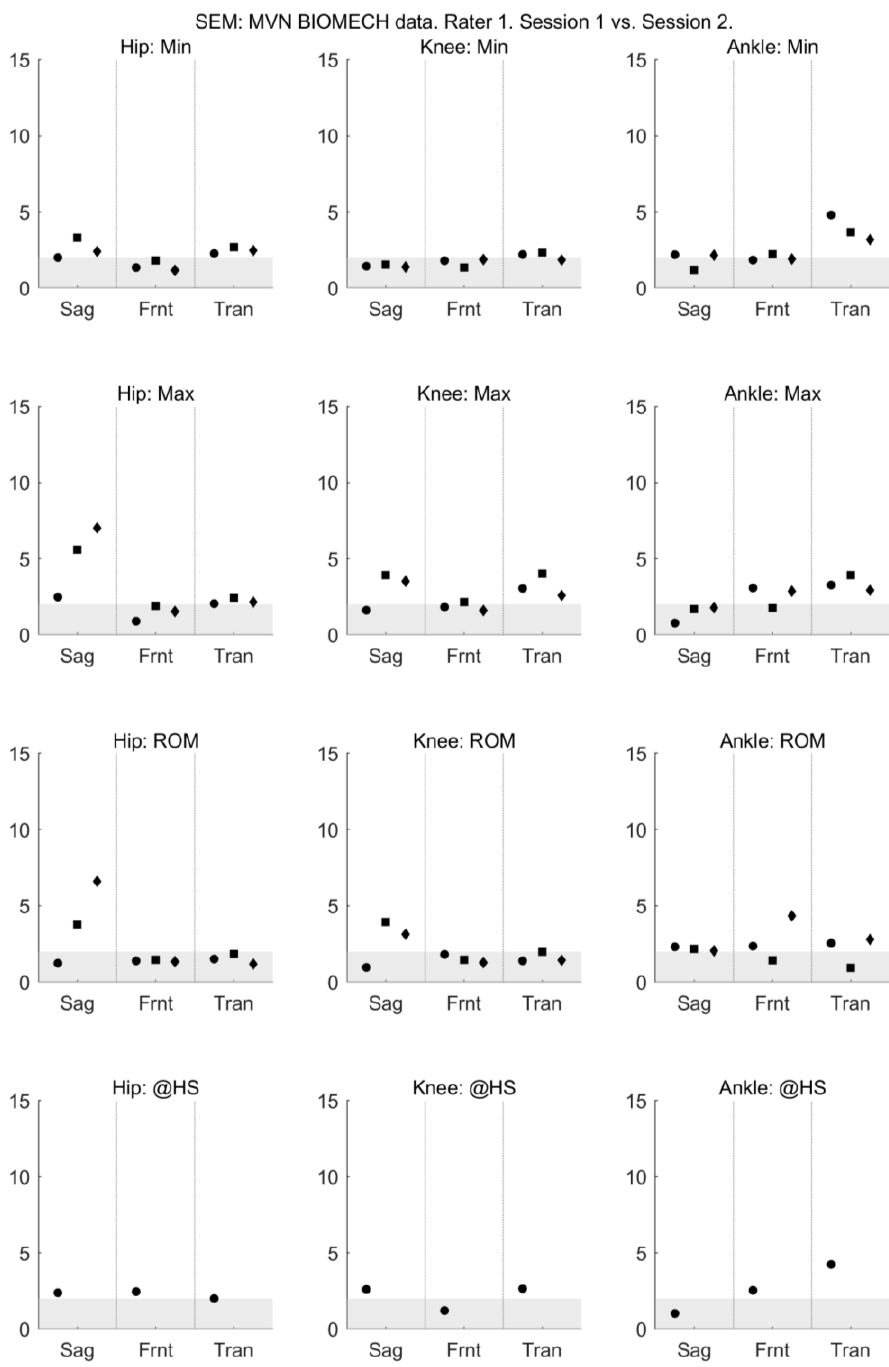
Figure 2. Between-session (within-rater) standard error of measurement of MVN data collected by rater 1 (musculoskeletal physiotherapist) in sessions 1 and 2. Standard error of measurement is shown for the minimum angle (min; top row ), maximum angle (max; second row ), range of motion (ROM; third row ) and angle at heel strike (@HS; bottom row) for the hip (left-most column), knee (centre column) and ankle (right-most column) joints in the sagittal (Sag), frontal (Frnt) and transverse (Tran) planes of movement. The three data points in each plane correspond to the walk (left-most point; circle), squat (centre point; square) and jump (right-most point; diamond) tasks. Grey shading indicates values considered to indicate excellent reliability.